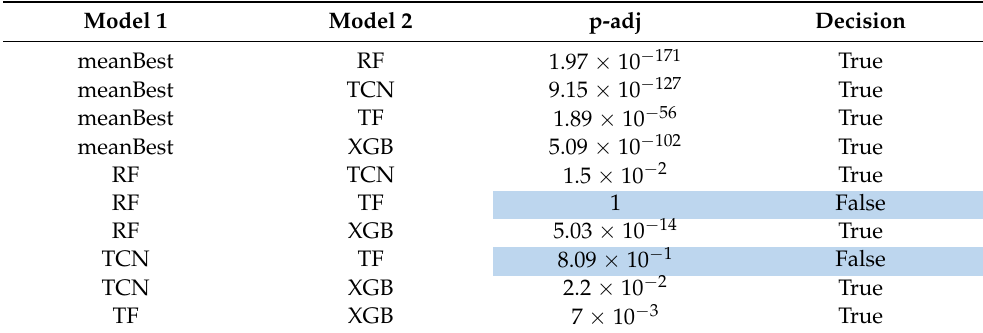
Table 4. ANOVA test results for building 1.